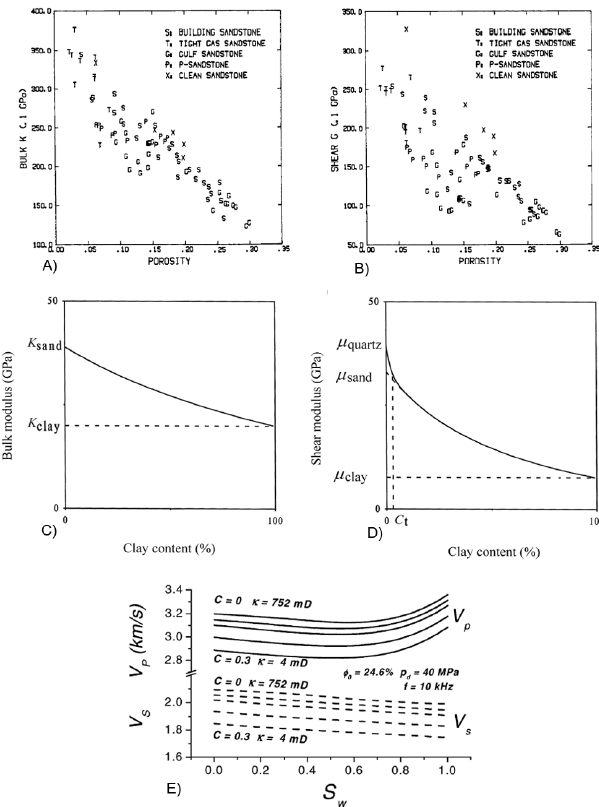
Fig. 4. Plots summarizing some literature studies on elastic moduli versus porosity and clay content. Modified after Han et al. (1986) (plots A–B ), Golberg and Gurevich (1998) (plots C–D ) and Pham et al. (2002) (plot E